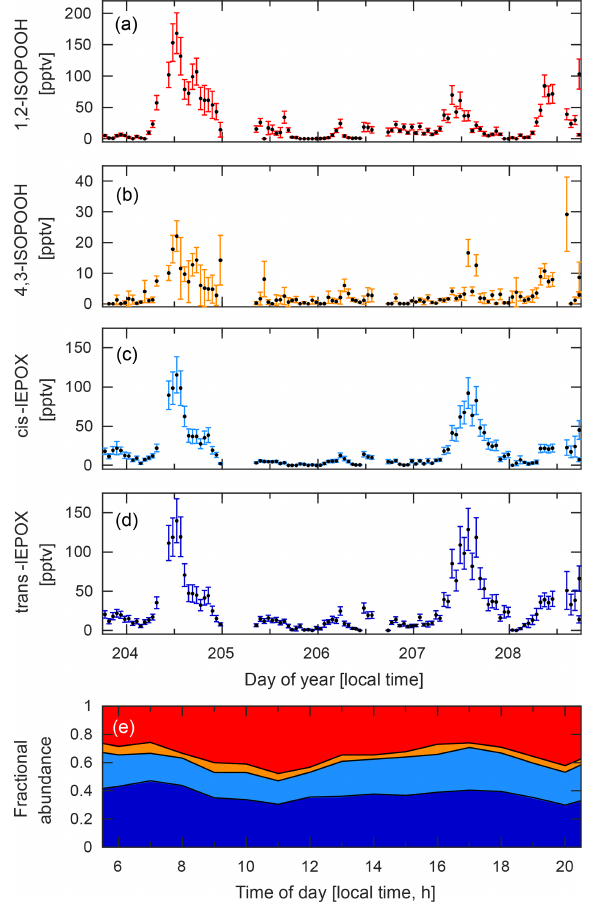
Figure 9. Time series for the four isobaric species: (a) 1,2- ISOPOOH, (b) 4,3-ISOPOOH, (c) cis -IEPOX, and (d) trans - IEPOX. Data were collected during the PROPHET campaign be- tween 22 and 27 July 2016. (e) Diurnal profile of the fractional abundance of each of these four isomers based on their hourly mean values calculated from the time series data shown here. Shaded areas correspond to 1,2-ISOPOOH (red), 4,3-ISOPOOH (orange), cis -IEPOX (light blue), and trans -IEPOX (dark blue).